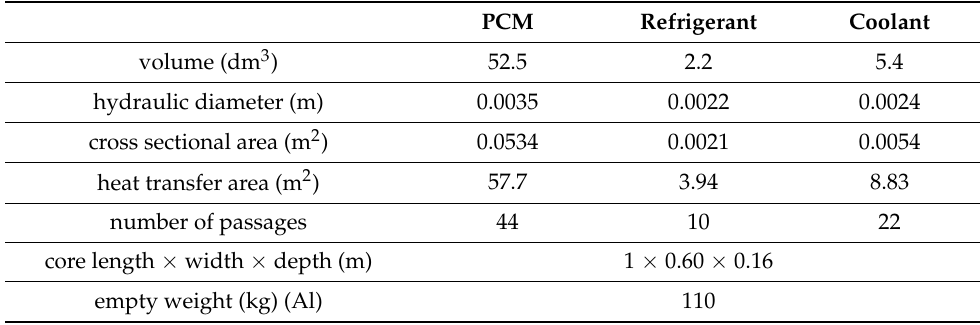
Figure 1. Channel distribution in the latent storage. Coolant indicates the HTF. Table 1. Main features of the latent TES investigated.